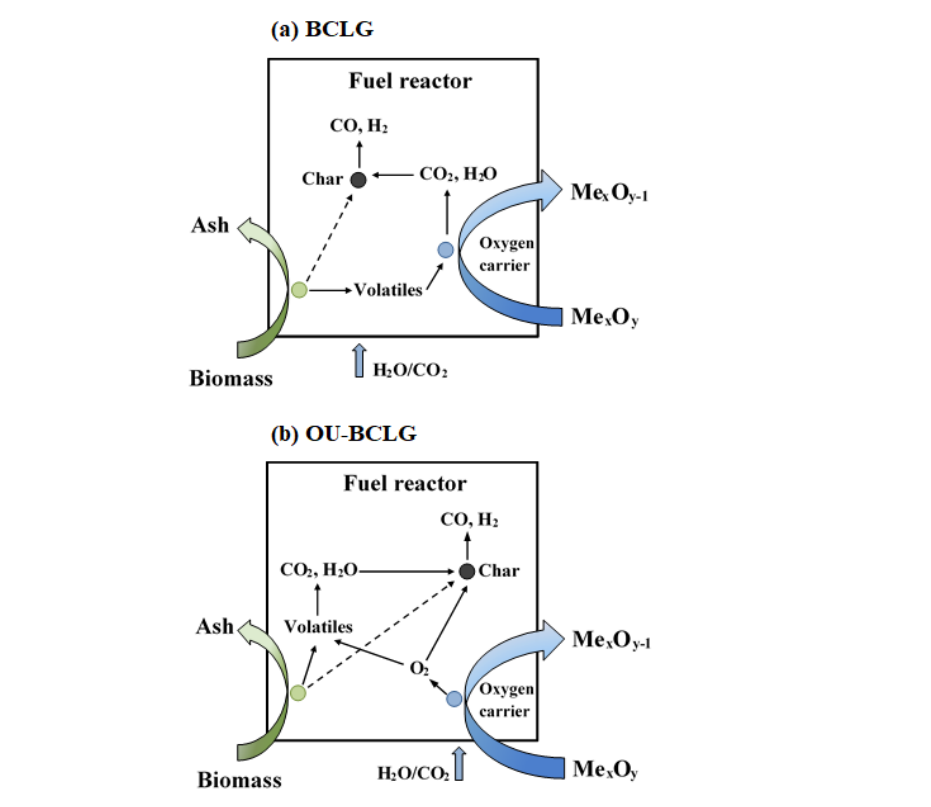
Figure 7. Main reactions in the fuel reactor: ( a ) BCLG and ( b ) OU-BCLG .